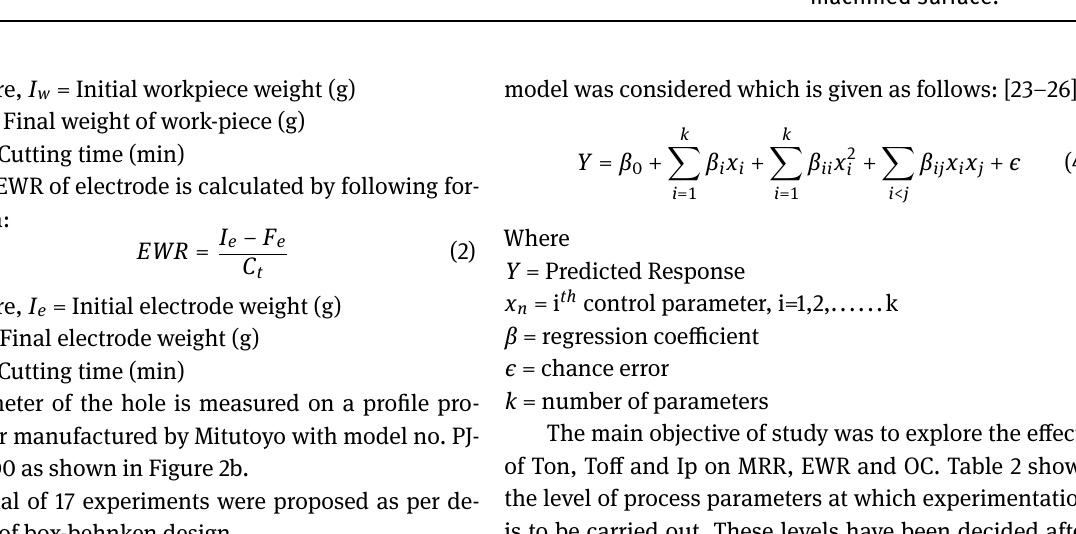
Due to increase of pulse on time the discharge energy increases on electrode. At low pulse off time results in an unstable process sand less time available for de-ionization. As a result, the cutting rate also increases. Higher the peak current is the width of peak wider and wider which results larger size of craters